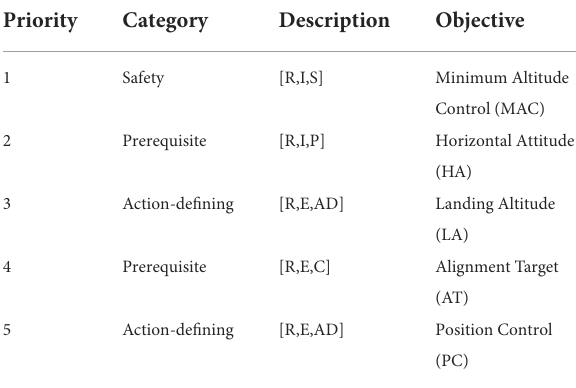
TABLE 1 Control tasks and